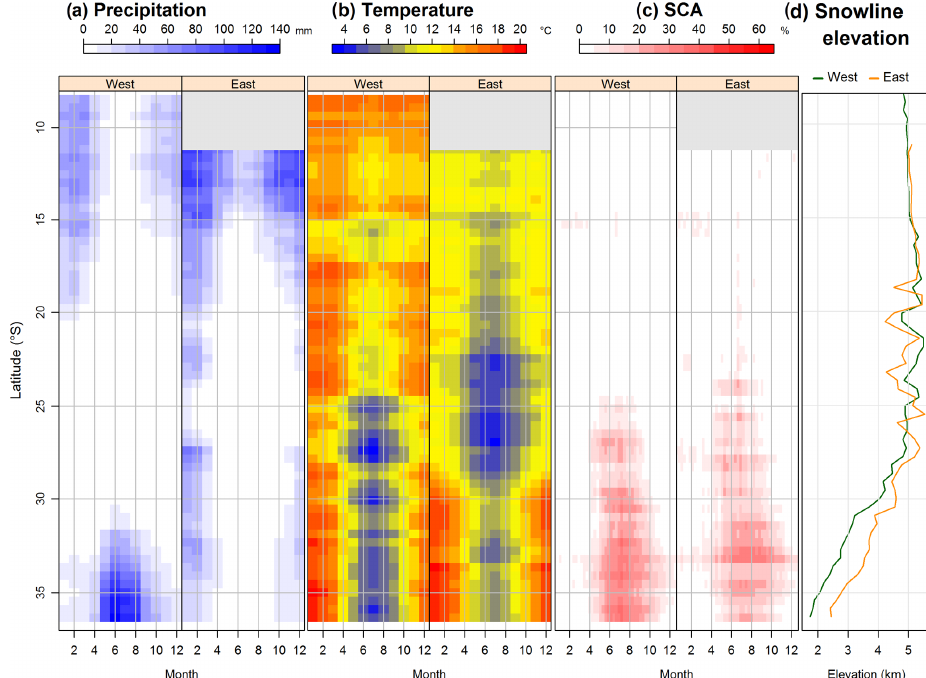
Figure 2. Mean monthly hydroclimate variables on the side of the continental divide (west–east) and latitude band for the period 2000–2016 for (a) precipitation and (b) temperature from the MERRA2 dataset, and (c) fraction of area with snow cover calculated from the binary 8-day product from MODIS (MOD10A2). (d) The snowline elevation (SP = 20%) was derived using the methods of Saavedra et al. (2017). Gray areas represent latitudes masked due to high frequency of cloud cover in snow-covered area analysis ( > 30% time period).